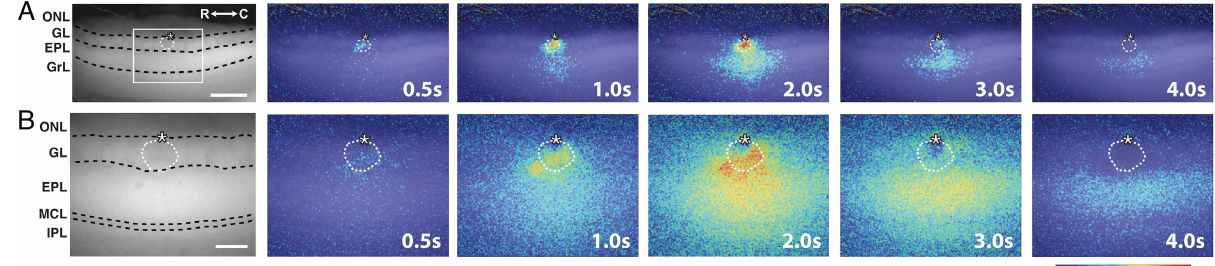
Fig 2. Intrinsic flavoprotein signal response in olfactory bulb upon electrical stimulation of canonical glomerulus. (A) (left) Resting light fluorescent image of a horizontal MOB slice under 4x magnification. (right) Representative overlaid, pseudo-colored Δ F/F frames showingthe signal spreadfollowinginitiationof train stimulationat 0s. Scale bar = 400 μ m. (B) (left) Resting light fluorescent image of the demarcated regionof the same slice in (A) at 10x magnification. (right) Representative overlaid,pseudo-colored Δ F/F frames following initiationof train stimulationat 0s. ONL, olfactory nerve layer; GL, glomerularlayer; EPL, externalplexiform layer; MCL, mitral cell layer; IPL, internalplexiform layer; GrL, granule cell layer; R, rostral; C, caudal. Asterisk, tip of the stimulatingelectrode. Targeted glomerulusindicated by dashedcircle. Scale bar = 150 μ m.